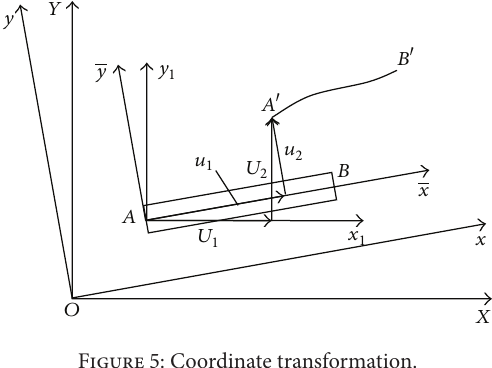
Figure 5: Coordinate